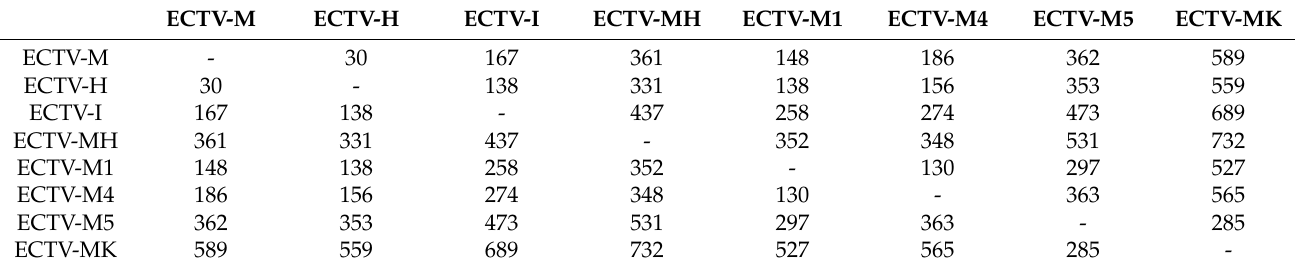
Table 3. Number of nt differences among ECTV